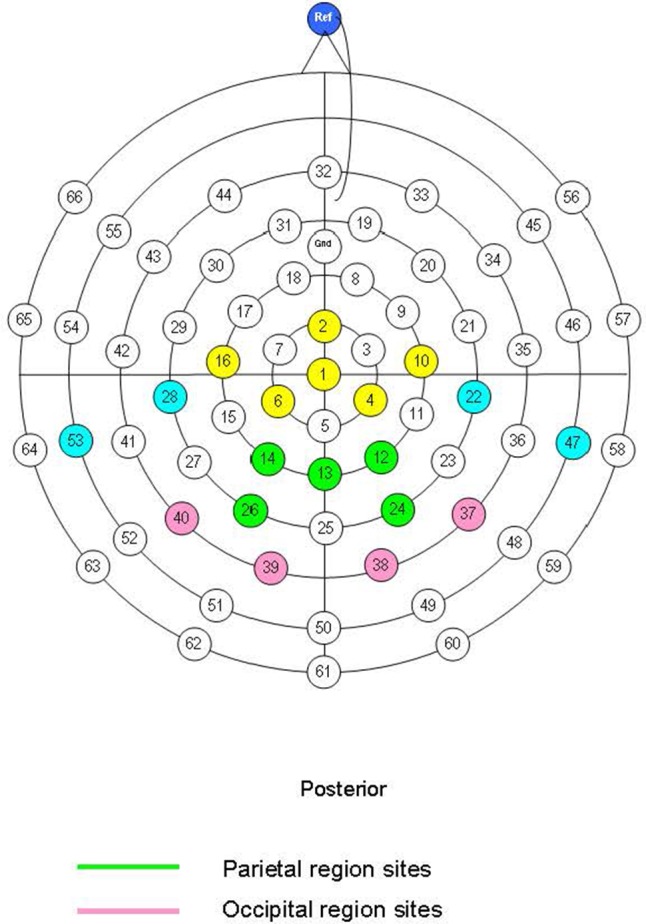
Montage with 19 sites used in EEG recording highlighted in yellow, blue, green, and pink. Sites used in analyses highlighted in green and pink for the parietal and occipital regions, respectively.